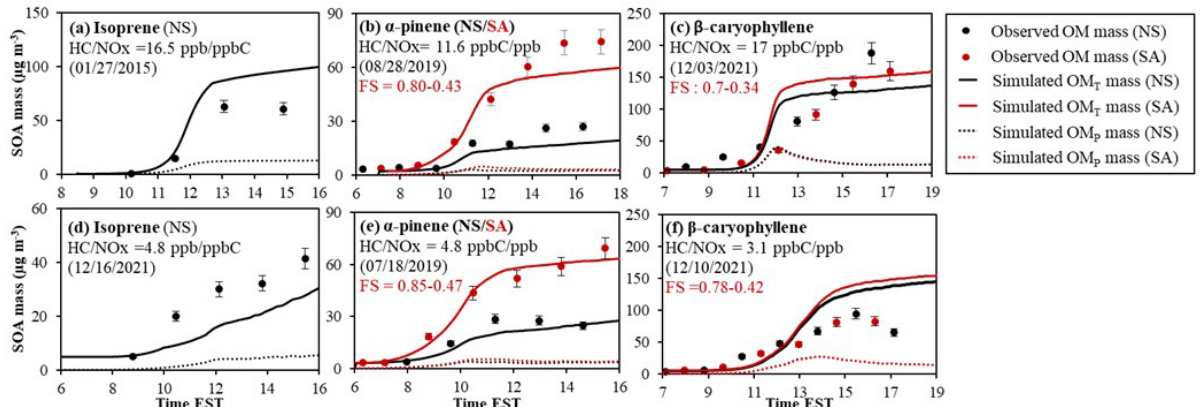
Figure 3. Observed (point) and simulated SOA mass (line) for the photooxidation of isoprene (a, d) , α -pinene (b, e) , and β - caryophyllene (c, f) under different seed conditions and NO x levels. SOA mass concentrations are corrected for the particle loss to the chamber wall. The simulated OM T (solid line) and OM P (dotted line) are also illustrated. The error (10%) associated with SOA mass was estimated with the instrumental uncertainty. NS and SA indicate non-seeded and sulfuric-acid-seeded experiments, respectively.